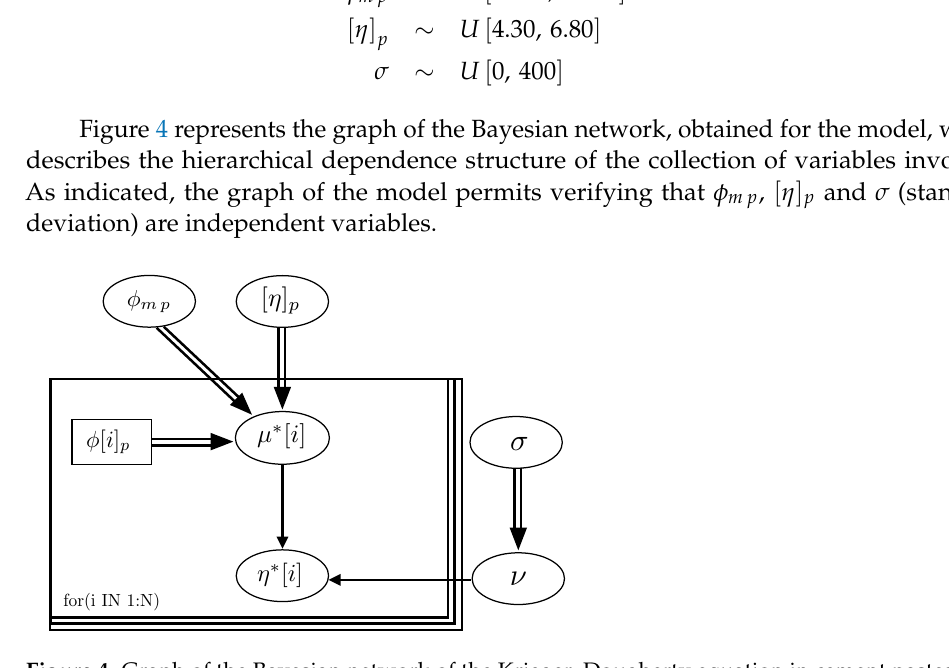
Figure 4. Graph of the Bayesian network of the Krieger–Dougherty equation in cement pastes. Table 4 summarizes the statistics calculated after performing the Bayesian analysis.